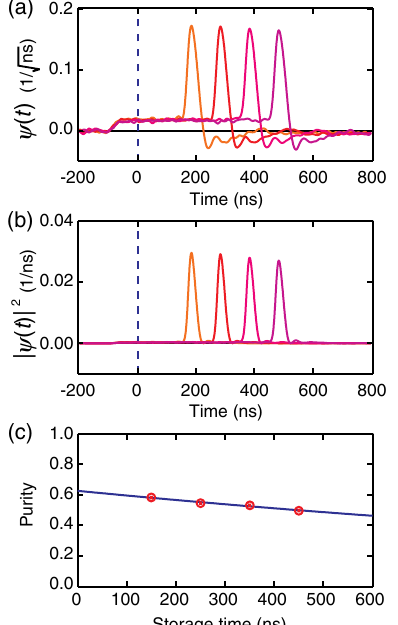
FIG. 3. Experimental dependencies on the storage time. (a) Estimated wave-packet envelopes of the released photons. The storage times are 0, 100, 200, and 300 ns, in addition to the intrinsic 150 ns. (b) Absolute square of the envelopes in (a), proportional to the photon probability density with respect to time. (c) Decay of the single-photon component with respect to the storage time, including the intrinsic delay of 150 ns. The red curves represent the experimental values of 58 : 2% , 54 : 6% , 53 : 1% , and 49 : 7% , with error bars of (cid:3) 0 : 5% . The error is roughly estimated by the bootstrap method [46]. The blue, exponential fitting curve P ð t Þ ¼ P ð 0 Þ exp ð(cid:1) t=(cid:2) Þ , where P ð 0 Þ ¼ 62 : 6% and (cid:2) ¼ 1 : 98 (cid:1) s